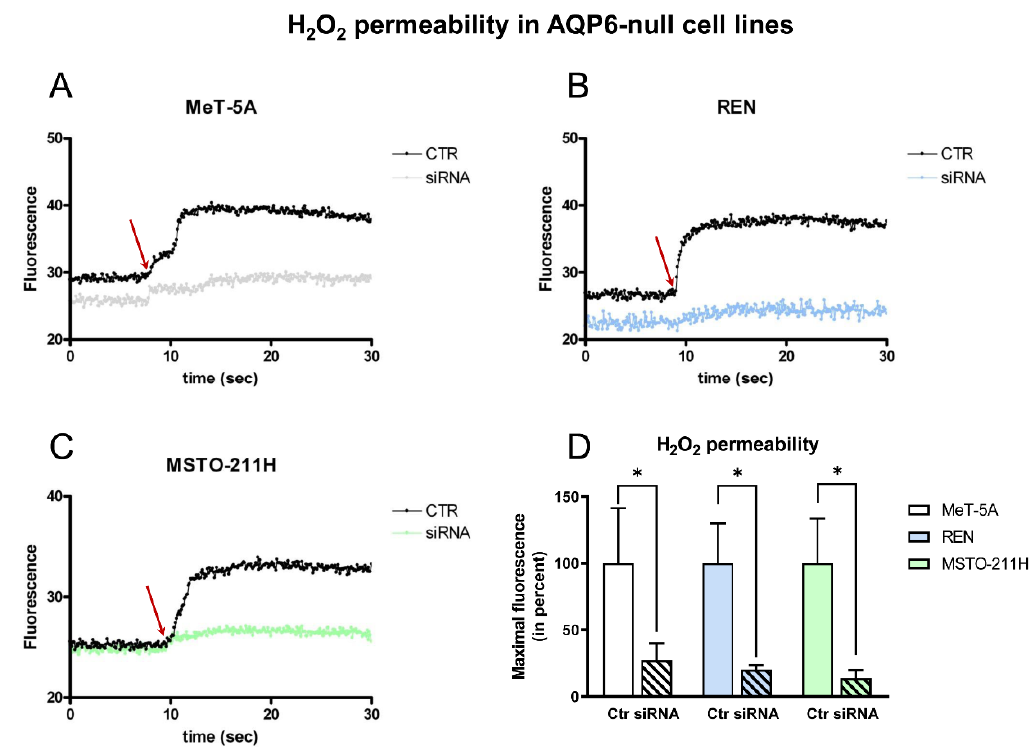
Figure 8. Effect of aquaporin-6 (AQP6) silencing on the H 2 O 2 permeability MeT-5A ( A ), REN ( B ), and MSTO-211H ( C ) cell lines. ( A–C ) HeLa cells were silenced with AQP6 siRNA and then transiently transfected with HyPer7 sensor, as described in Materials and Methods. Control (scrambled; CTR) and silenced cells (siRNA) were exposed to 50 μ M H 2 O 2 gradient (final concentration). Curves show the time course of H 2 O 2 transported into the cells after H 2 O 2 injection (red arrow). ( D ) Bars represent the H 2 O 2 permeability of cells expressed as a percent of maximal fluorescence. Values are means ± SEM of cells for each of 3 different experiments in triplicates. *, p = 0.0414, p = 0.0260, p = 0.0275 versus Ctr, for Met-5A, REN, and MSTO-211H, respectively (Brown–Forsythe and Welch ANOVA tests).